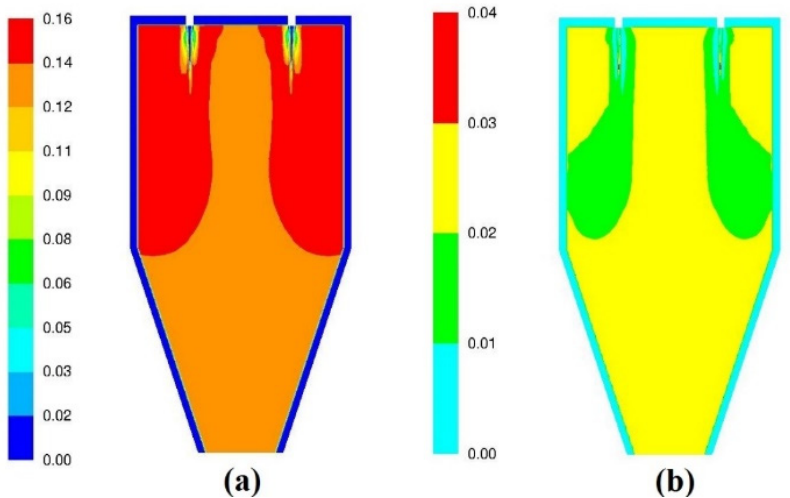
Figure 22. Species distribution in the plane passing through the centers of two opposite burners: ( a ) CO and ( b ) CO 2 .